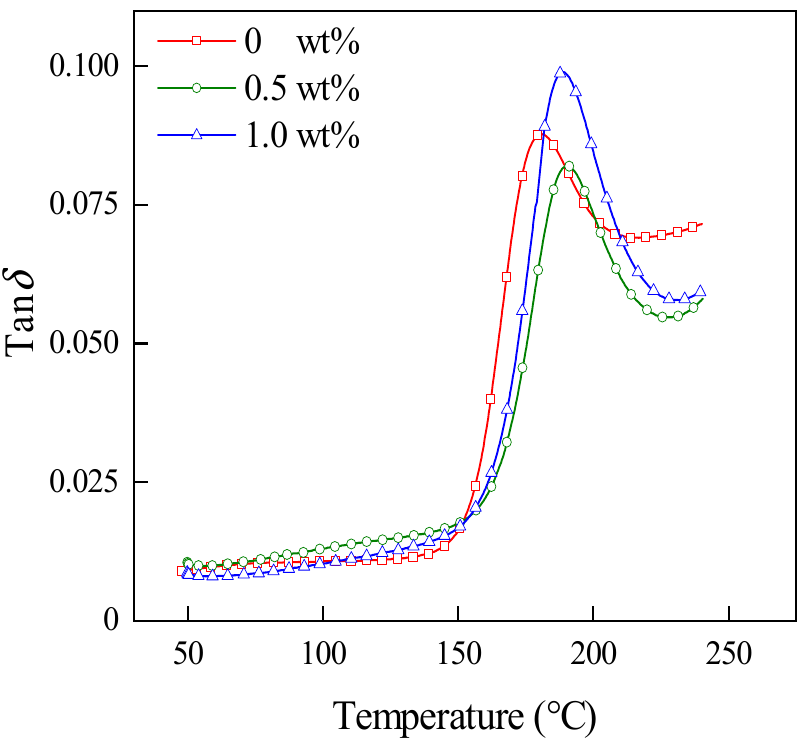
Figure 12. The tan δ -temperature curves of laminates with different CNT contents.